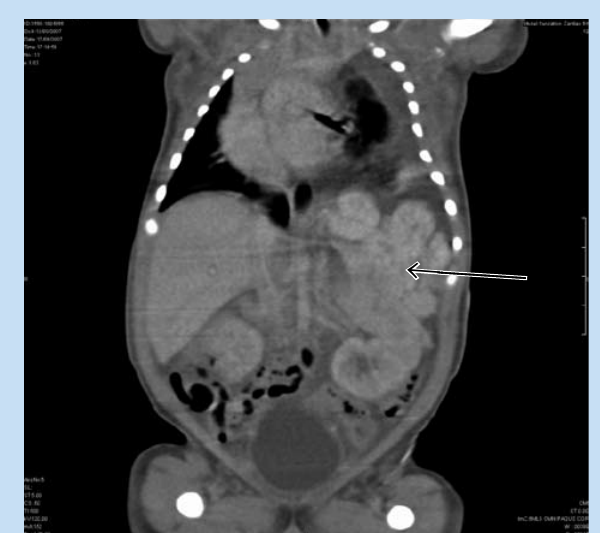
Fig. 2a. Coronal CT image: enhancing, lobulated mass (arrow), displacing intra-abdominal viscera and reactive left pleural effusion.